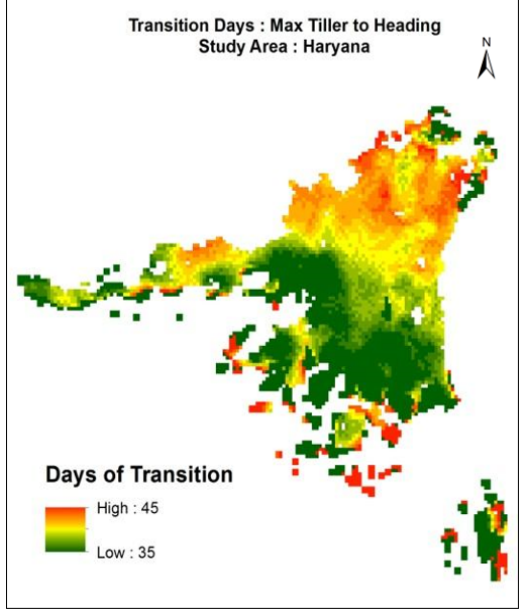
Figure 10: Transition to Heading of Rice crop in Haryana 4.2.5